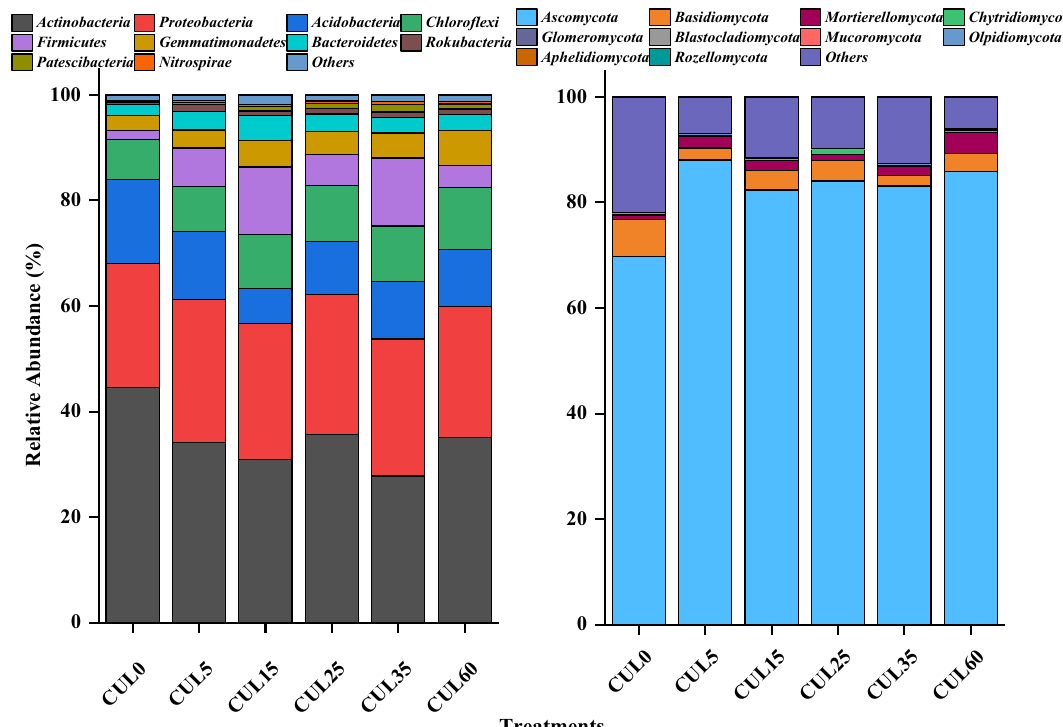
Fig. 2 The relative abundances of primary bacterial ( A ) and fungal ( B ) communities at phylum level in response to different periods of continuous cultivation